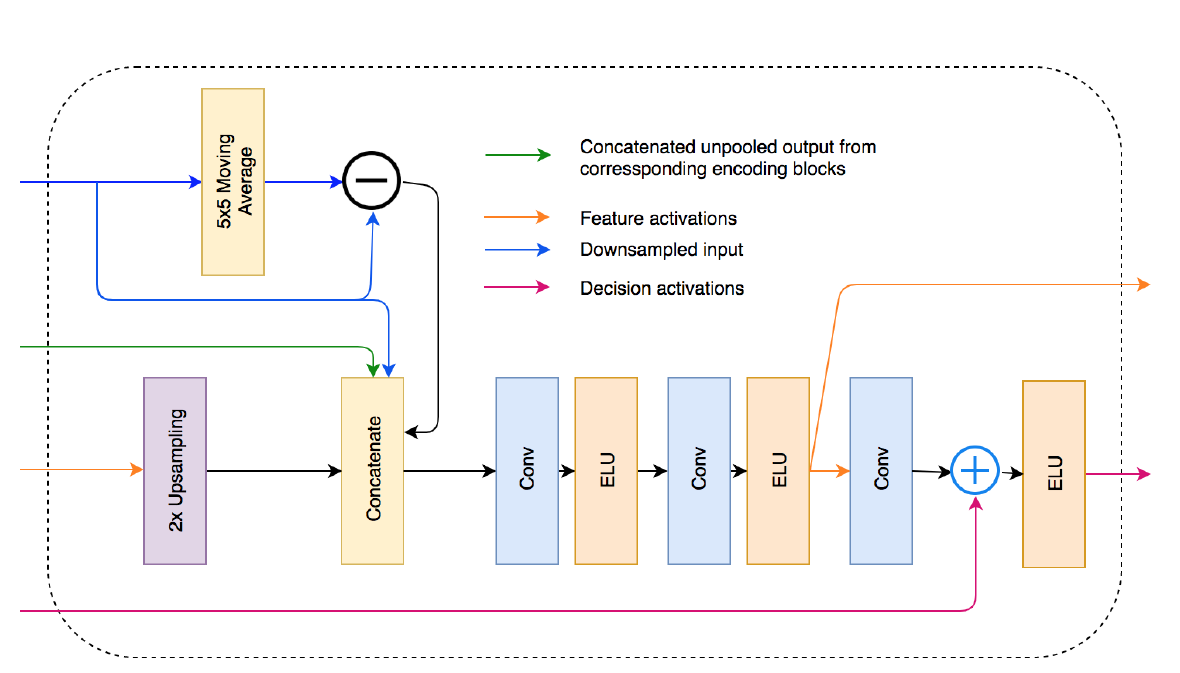
Figure 3. Decoder